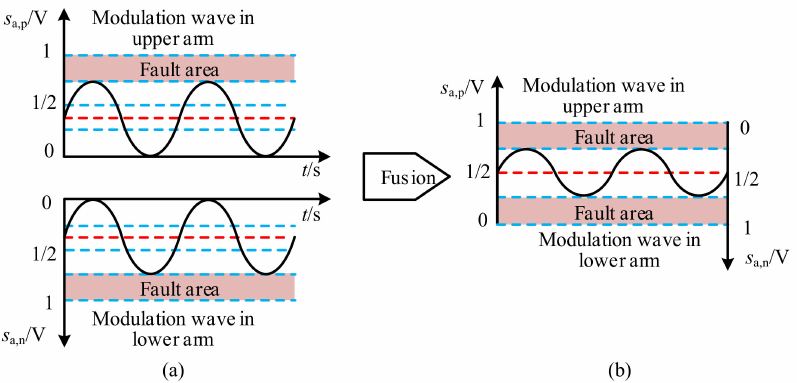
Figure 6. The fault information fusion of a single-phase bridge arm ( N = 4). ( a ) Modulation wave before single-phase fusion; ( b ) Modulation wave after single-phase